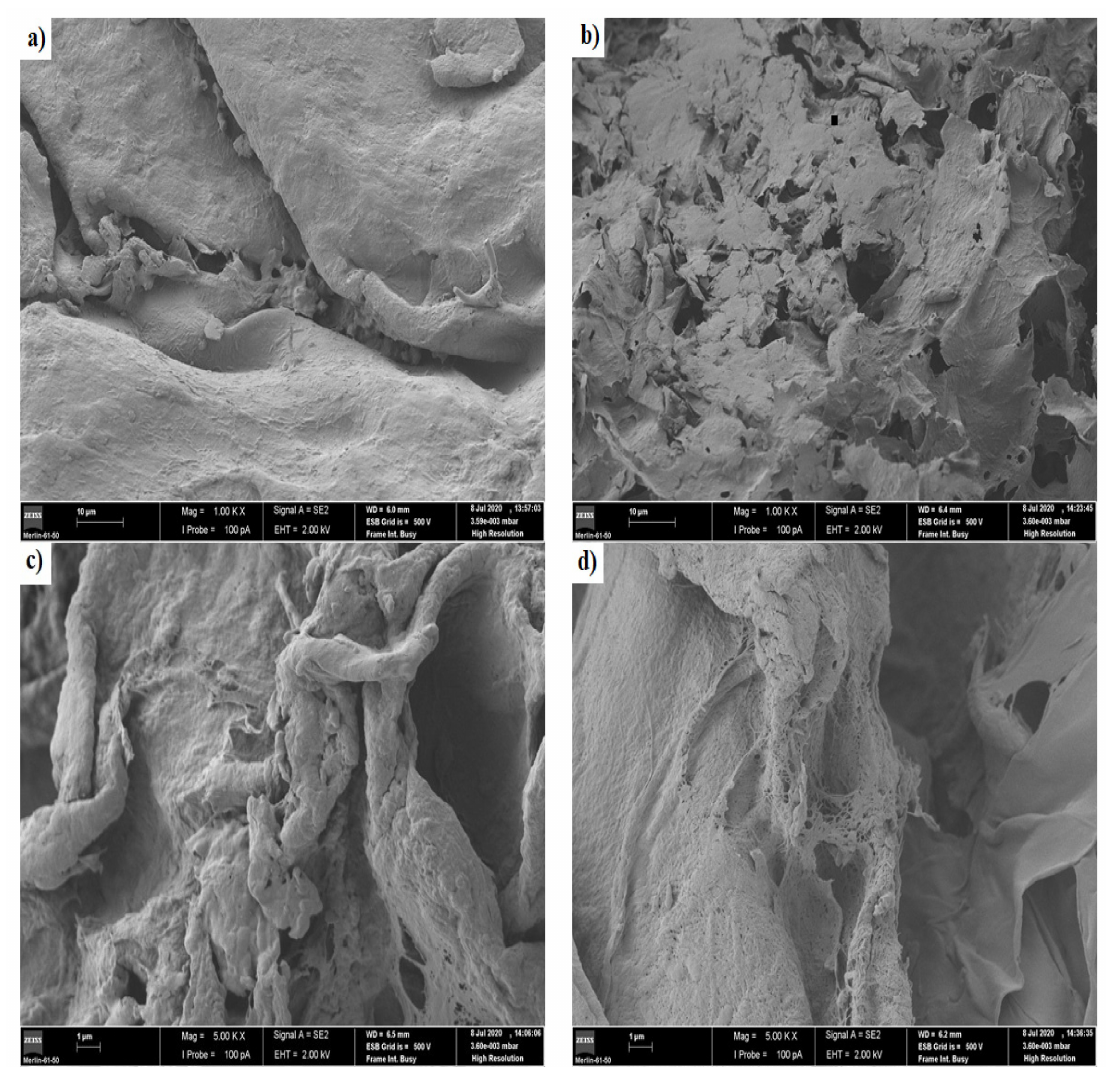
Figure 6. Images of scanning electron microscopy for the chitosan/pectin hydrogel ( a , b ) and chitosan/DNA hydrogel ( c , d ) before loading methylene blue ( a , c ) and after loading methylene blue ( b , d ).